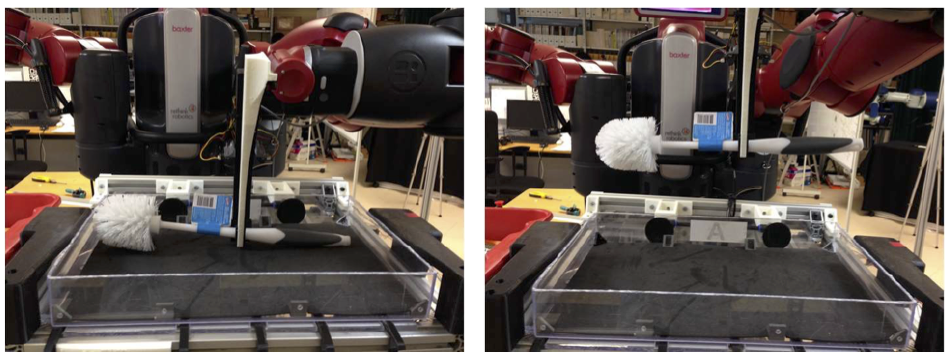
Figure 18. HAF with Pincher; successful grasp of the toilet